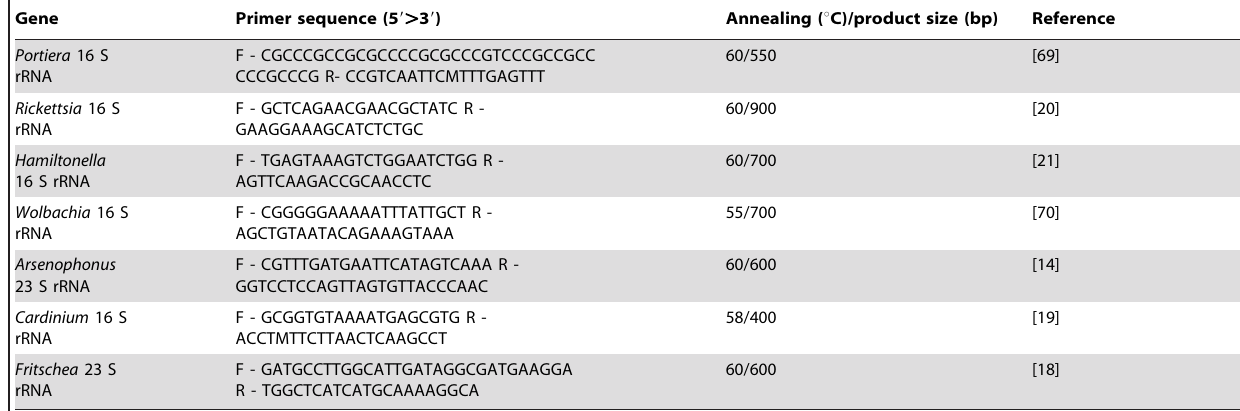
Gene Primer sequence (5 9.. 3 9